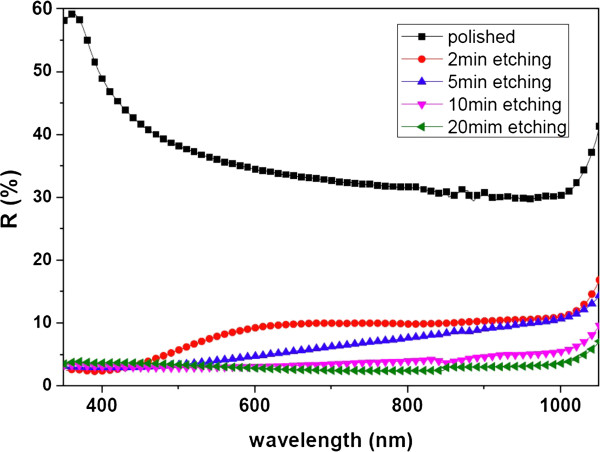
Reflectance spectra of polished c-Si and SiNW arrays with various lengths.